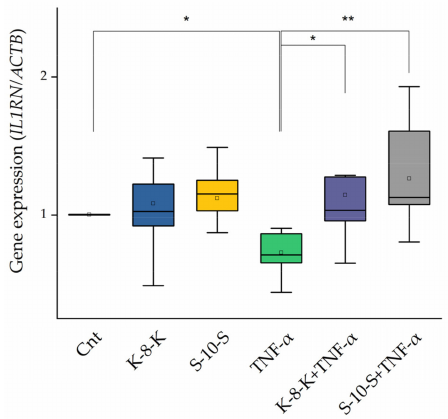
Figure 6. Gene expression analysis of anti-inflammatory cytokines in Caco-2 cells treated with K-8-K and S-10-S . qRT-PCR analysis of anti-inflammatory cytokine, IL-1ra, gene expression ( IL1RN ) was carried out in mRNA samples of Caco-2 cells treated with K-8-K and S-10-S subjected to induction of inflammation by 2 ng/mL TNF- α . β -Actin ( ACTB ) was used as a reference. Means of at least three replicates estimated in duplicate were compared (** p < 0.01, * p < 0.05). Cnt: untreated